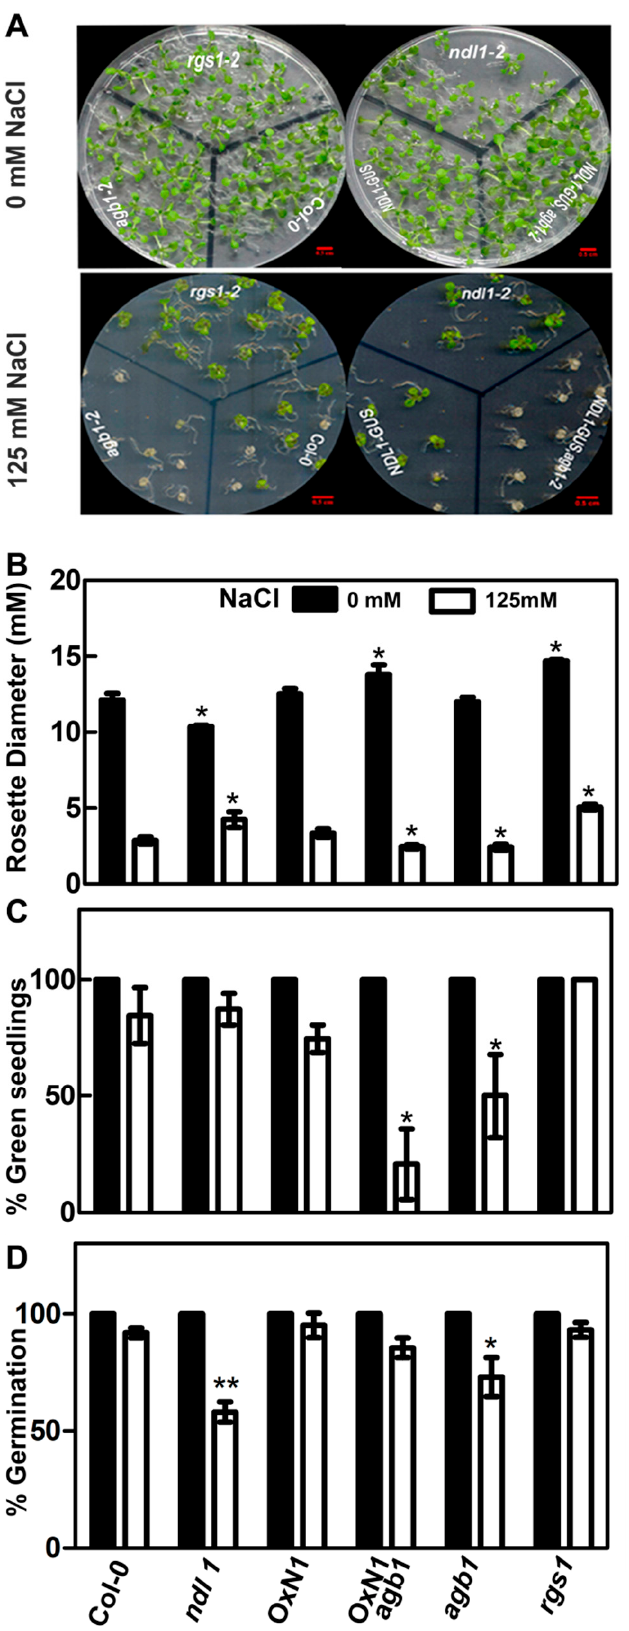
Figure 1. Phenotypic characterization of NDL1-AGB1 module response to salt stress. ( A ) Seedlings of Col-0; rgs1-2 ; agb1-2 ; ndl1-2 ; NDL-GUS (OXN1) and NDL-GUSagb1-2 (OxN1agb1) genotypes